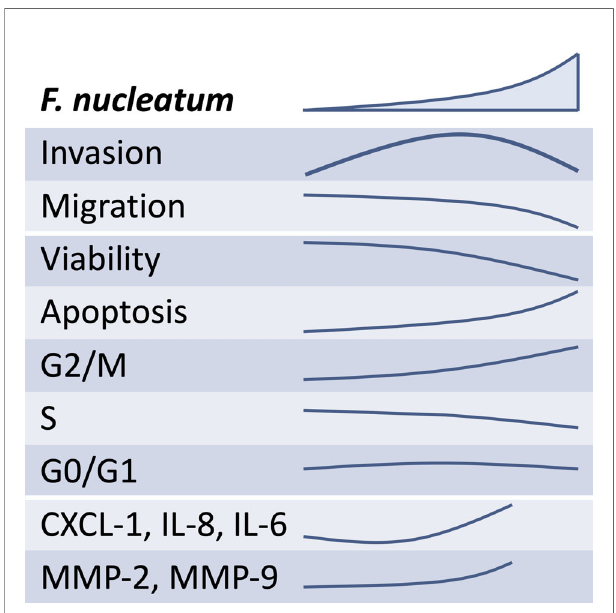
FIGURE 7 | Overview of the schematic effects of rising inactivated F. nucleatum concentrations on HTR8/SVneo. Main results of HTR8/SVneo trophoblastic cells in response to in vitro stimulation with F. nucleatum are summarized. F. nucleatum induced HTR8/SVneo invasion, secretion of soluble mediators (CXCL1, IL-6 and IL-8) and metalloproteinases (MMP-2 and MMP-9). As concentrations of F. nucleatum increased, these did not improve invasiveness, hindered migration, reduced cell viability and induced alterations in the cell